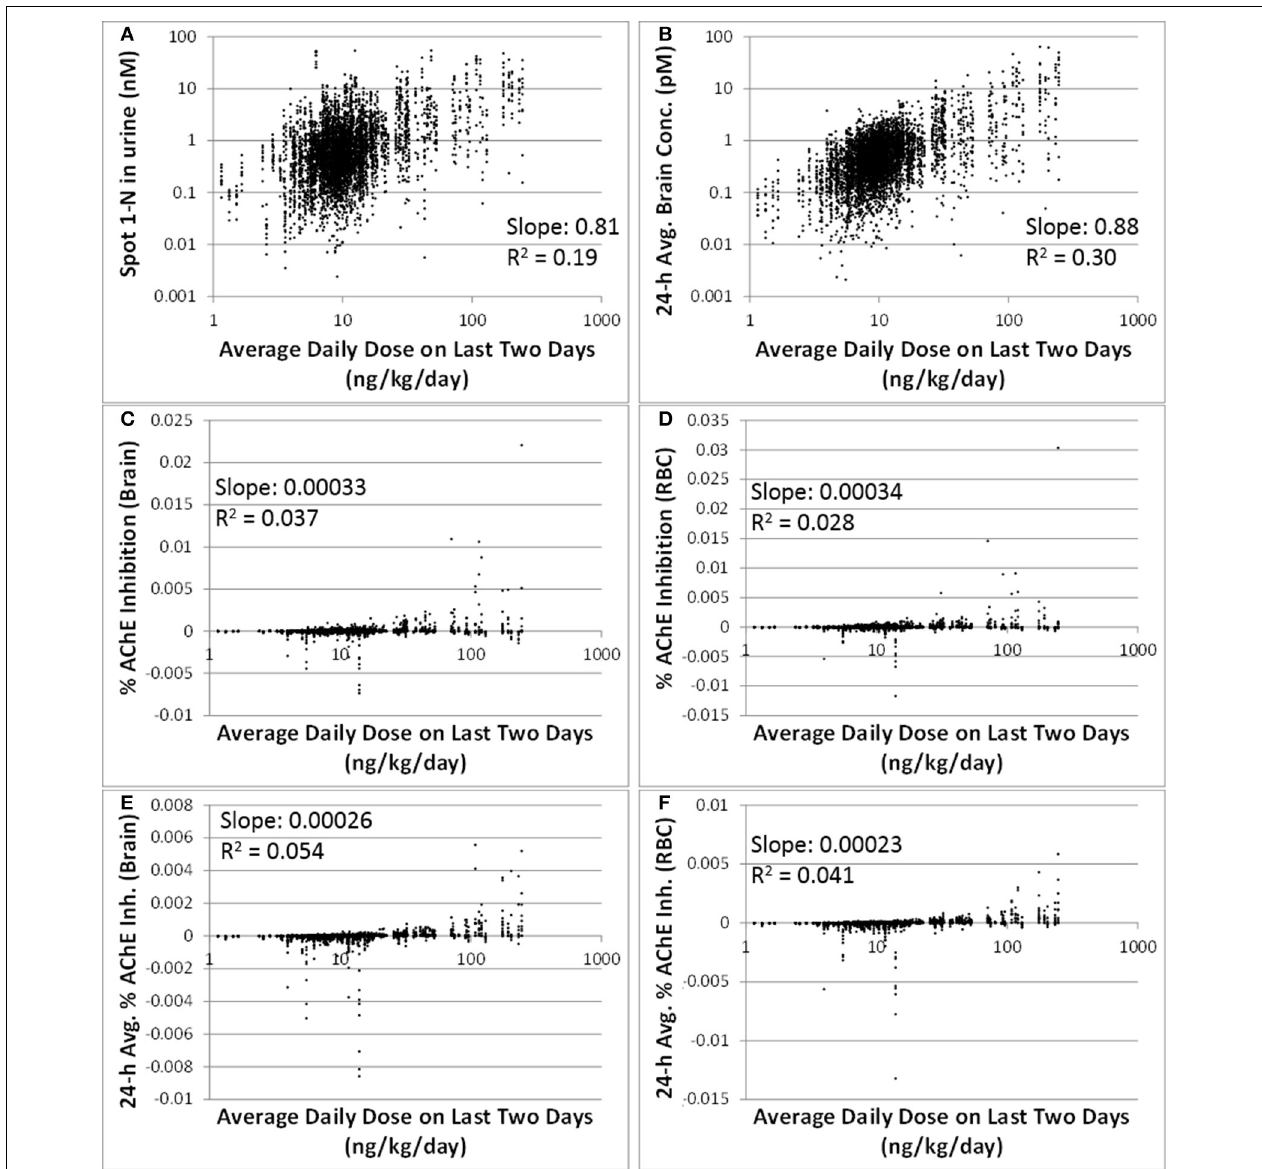
FIGURE 3 | Correlations between six model-output variables and the average daily doses over the last 2 days of exposure (ng/kg/day) for 5000 simulations. (A) biomarker of exposure: spot 1-N in urine (nM); (B) target tissue concentration: carbaryl concentrations in brain averaged over the 24h prior to sampling (pM); (C) Biomarker of early biochemical changes at the target tissue: percent AChE inhibition in